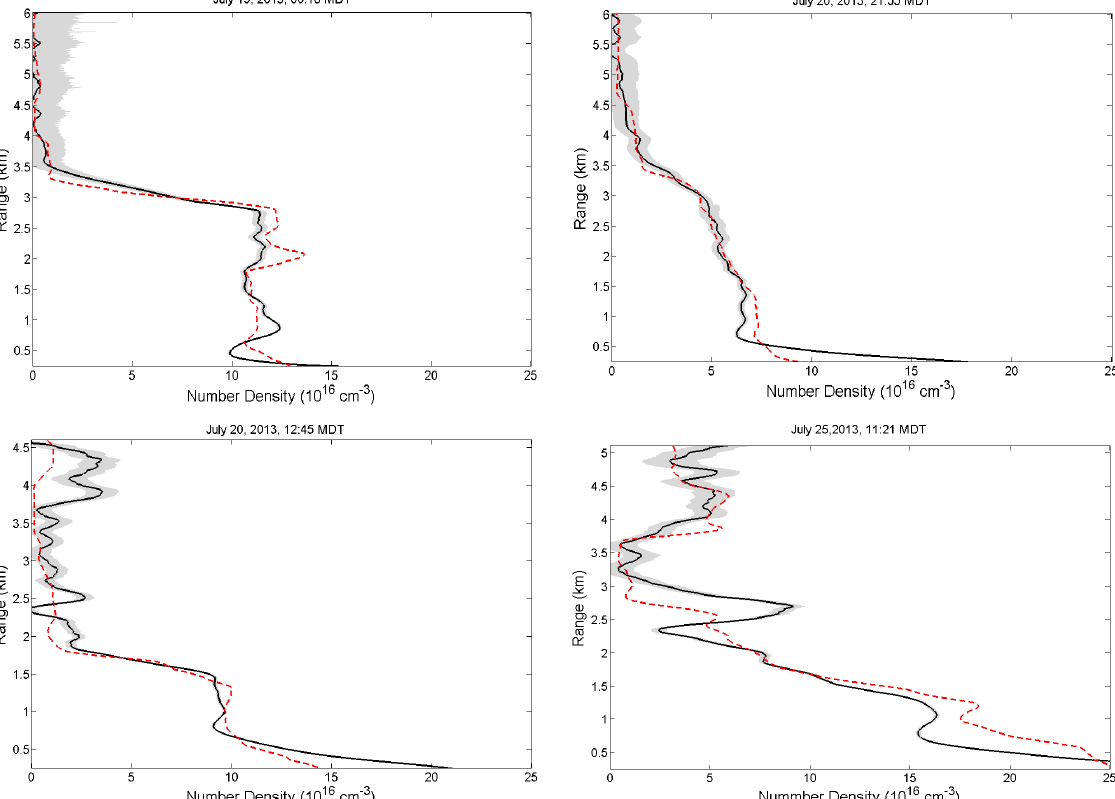
19 July 2013 at 00:16, 20 July 2013 at 21:55, 20 July 2013 at 12:45, and 25 July 2013 at 11:21, are shown in the top left , top right , bottom left , and bottom right plots, respectively. The dashed red line represents retrieved number density profiles based on the temperature and relative humidity measured by the radiosonde while the solid black line represents the water vapor number density retrieved from the DIAL at the time of the radiosonde launch. The upper left-hand, upper right-hand, lower left-hand, and lower right-hand